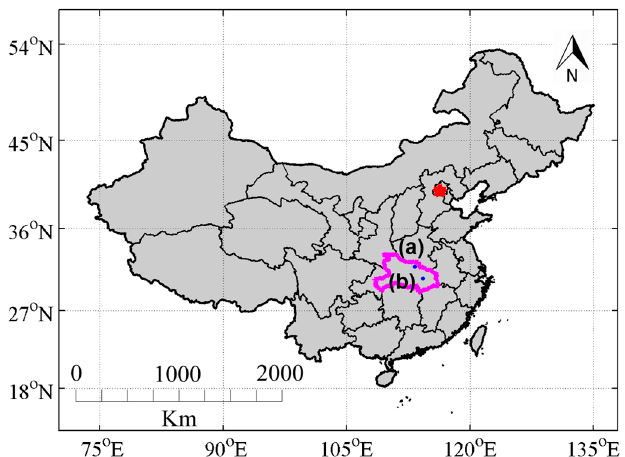
Figure 1. Locations of the two experimental fields: (a) Yongyou 4949, Junchuan County in Sui Zhou; (b) Yangliangyou 6, Huazhong Agricultural University in Wuhan.